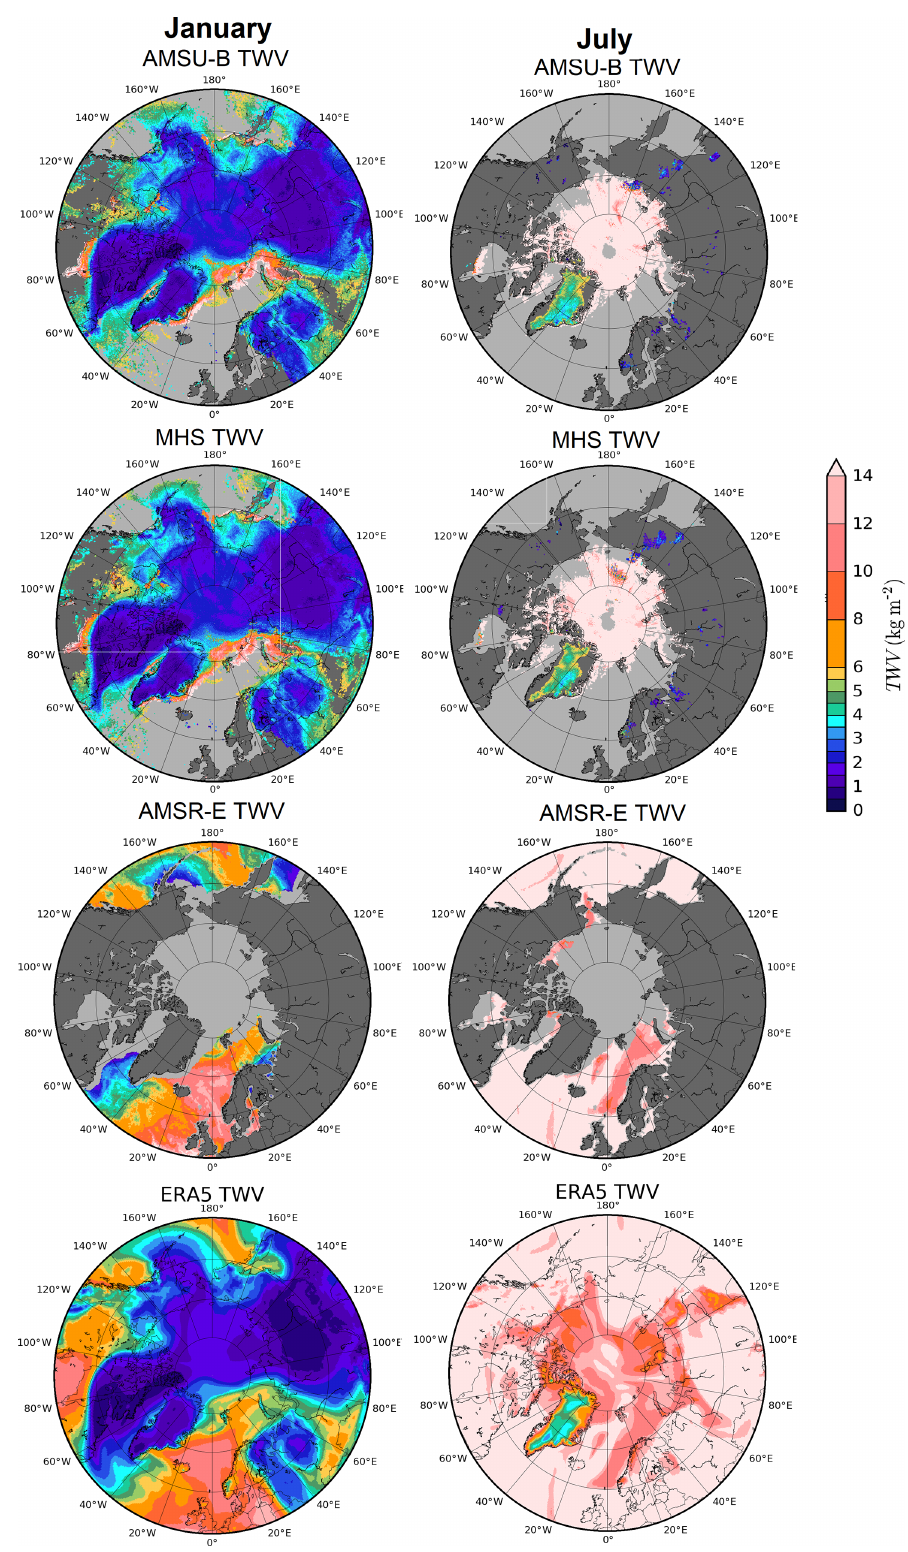
Figure 11. AMSU-B (top row), MHS (second row), AMSR-E (third row) and ERA5 (bottom row) TWV retrievals for winter (6 January 2008; left column) and summer (6 July 2008; right